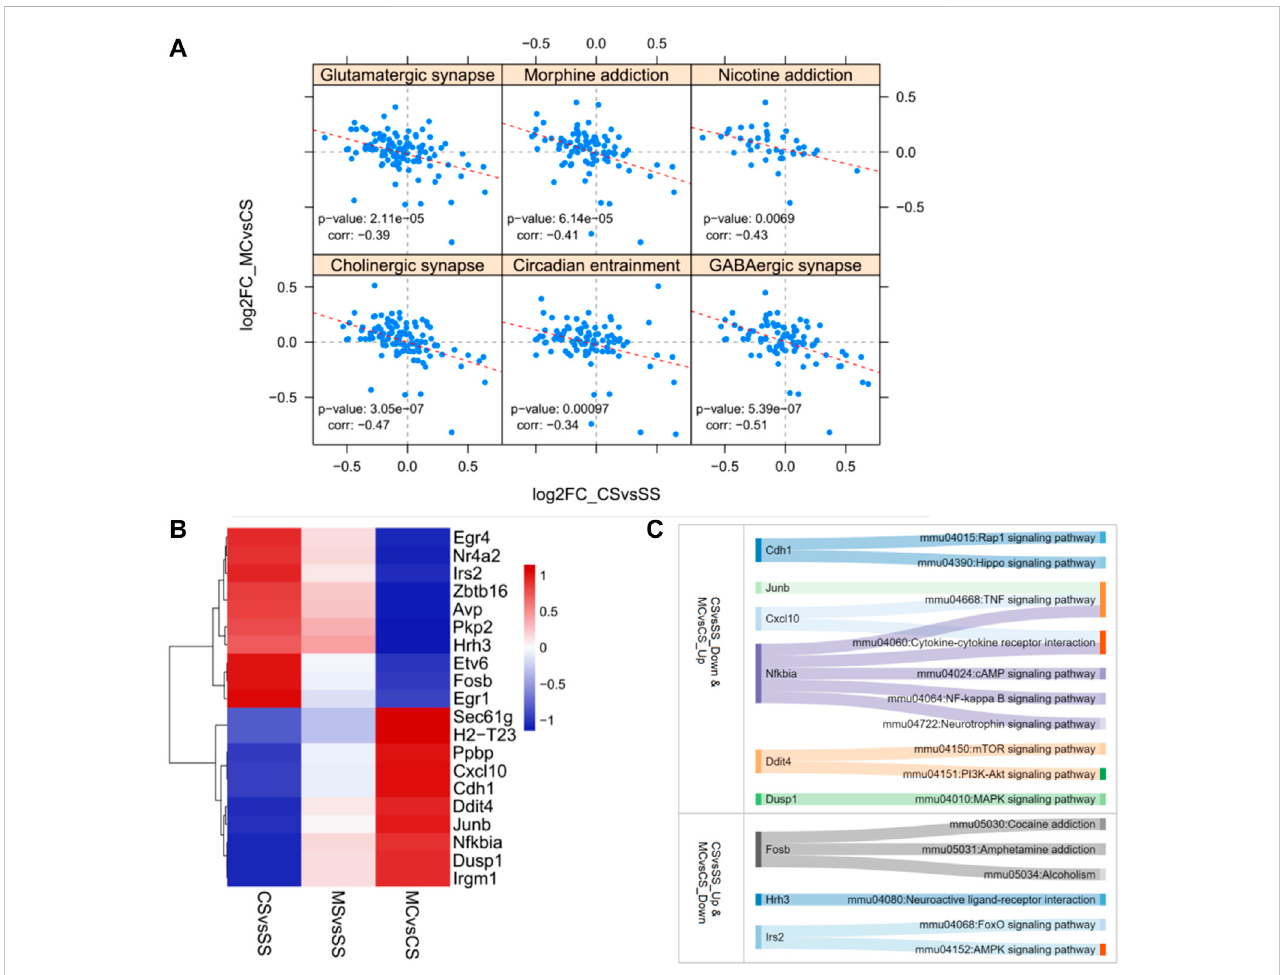
FIGURE 3 Reversely regulated genes by L-methionine (MET) response to cocaine CPP. (A) Scatter plot of all gene expression levels in substance dependence and drug abuse-related pathways. (B) Heatmap of the top 20 DEGs regulated by cocaine and reversed by MET. (C) Sankey diagram depicting the involved pathways of the top 20